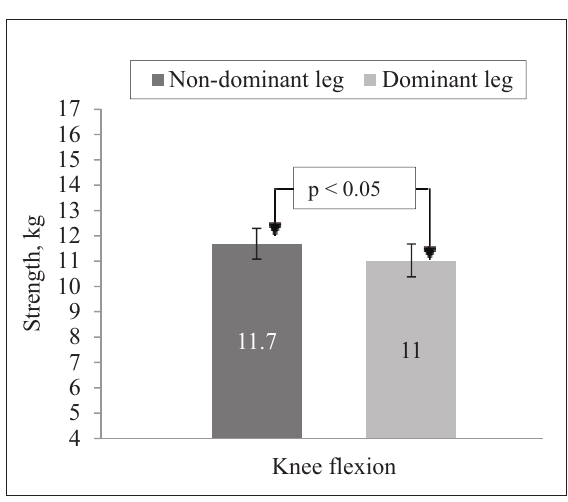
Figure 3. Change in the strength (kg) of muscles of the dominant and non-dominant leg of the female athletes after the knee flexion